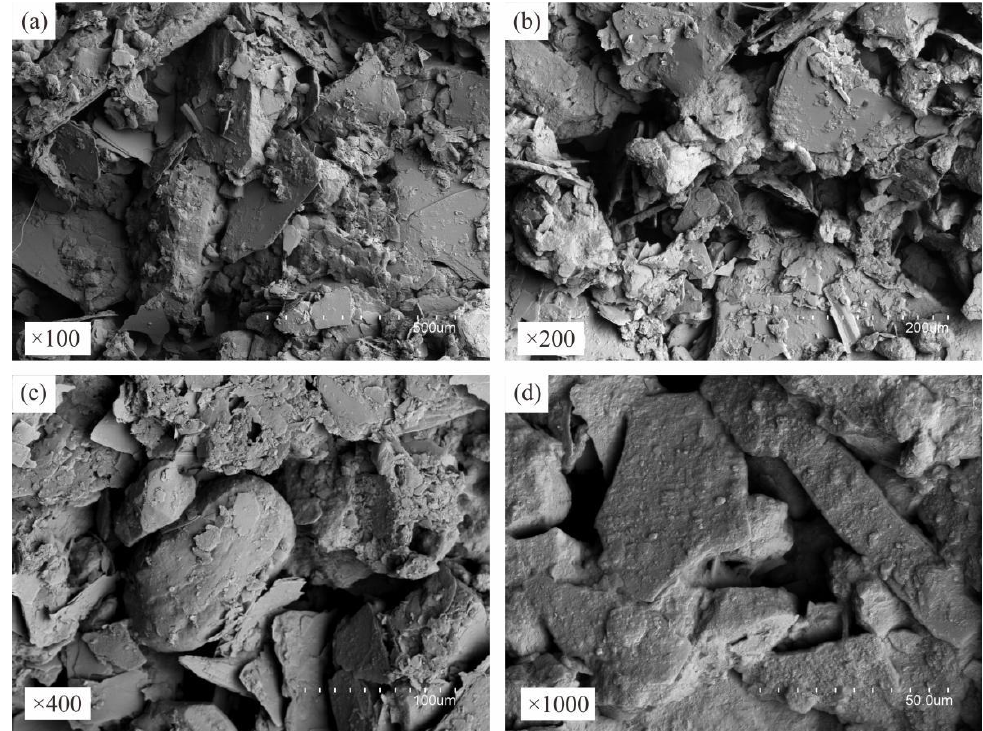
Figure 18. Enlarged scanned images at different magnifications. ( a ) Enlarged the scanned image by 100 times. ( b ) Enlarged the scanned image by 200 times. ( c ) Enlarged the scanned image by 400 times. ( d ) Enlarged the scanned image by 1000 times.